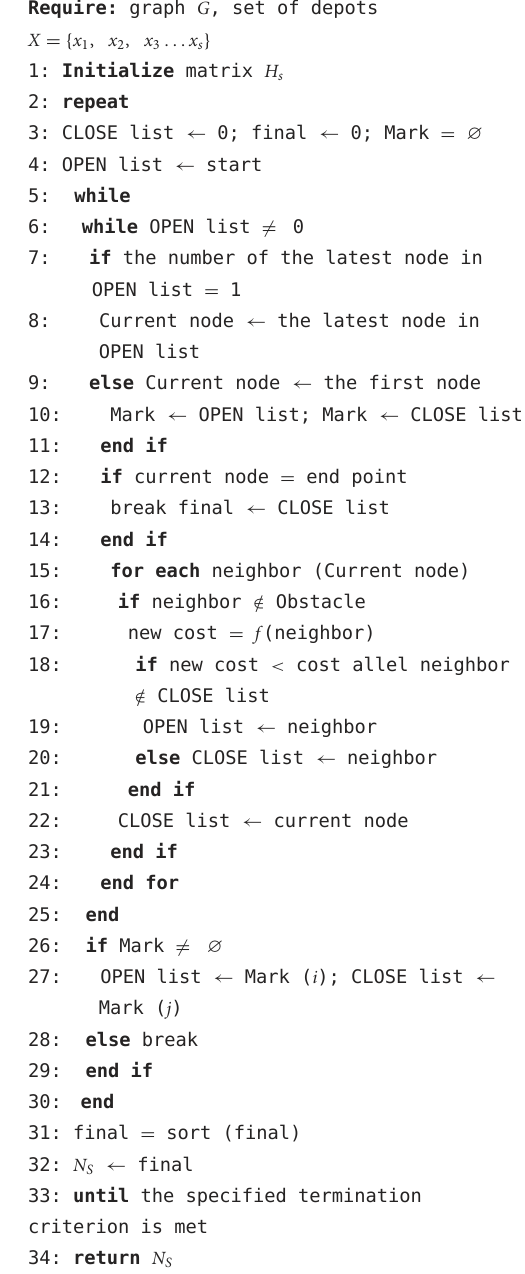
Algorithm 3. Improved A ∗ algorithm for establishing the path expert database.